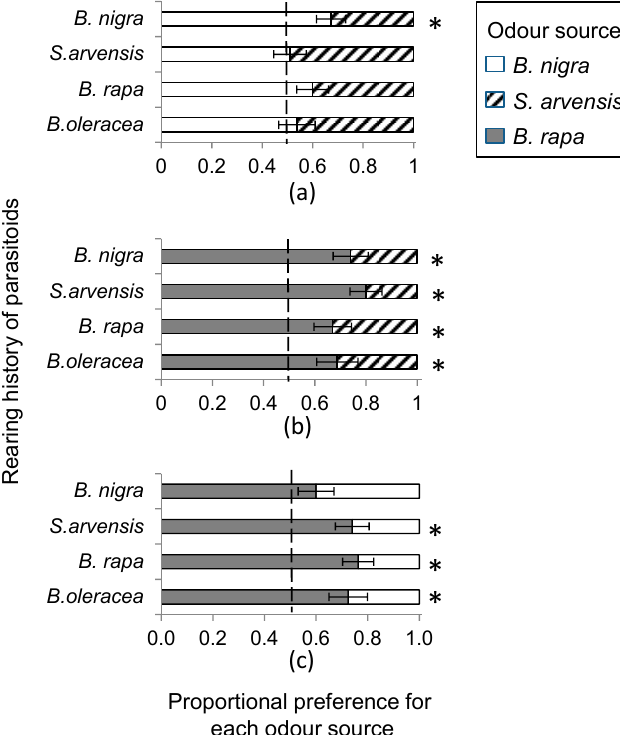
Figure 2. Landing preference of female Cotesia glomerata that had been reared on Brassica oleracea , Brassica rapa , Sinapis arvensis , or Brassica nigra , in a pair-wise choice assays with: ( a ) B. nigra ( white bars ) and S. arvensis ( dashed bars ); ( b ) B. rapa ( grey bars ) and S. arvensis ; or ( c ) B. rapa and B. nigra when infested with Pierisrs brassicae caterpillars for 24 h. Bars present the mean proportion (±standard error of the mean or SE) of choice based on 10 replicate bioassays each tested with 10 responding wasps. An asterisk indicates a significant preference within a plant pair.